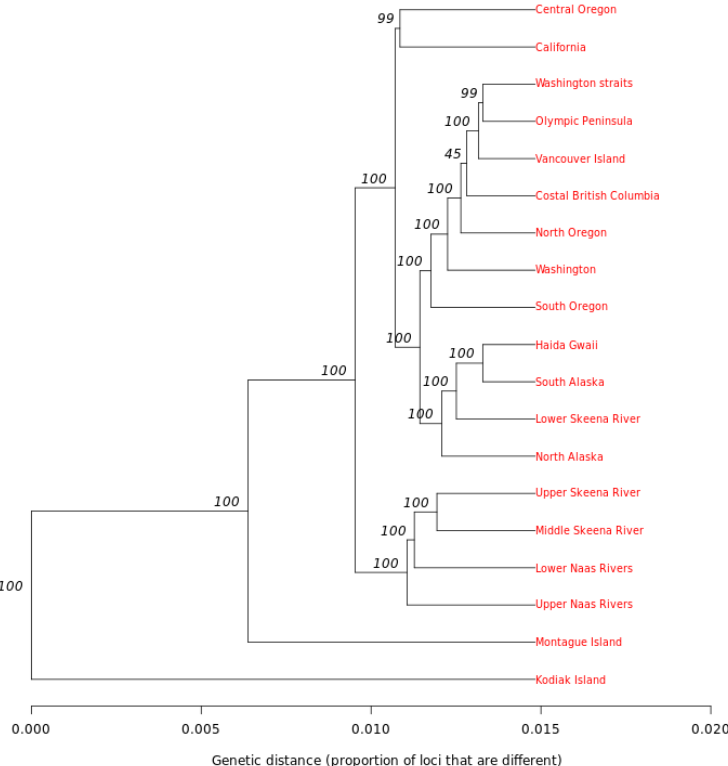
Figure 4. Genetic clustering of geographic regions. Tree was constructed by using pairwise genetic distance between loci, using the UPGMA method, which employed Nei’s genetic distance. Numbers above branches represent bootstrap values (100 replicates).